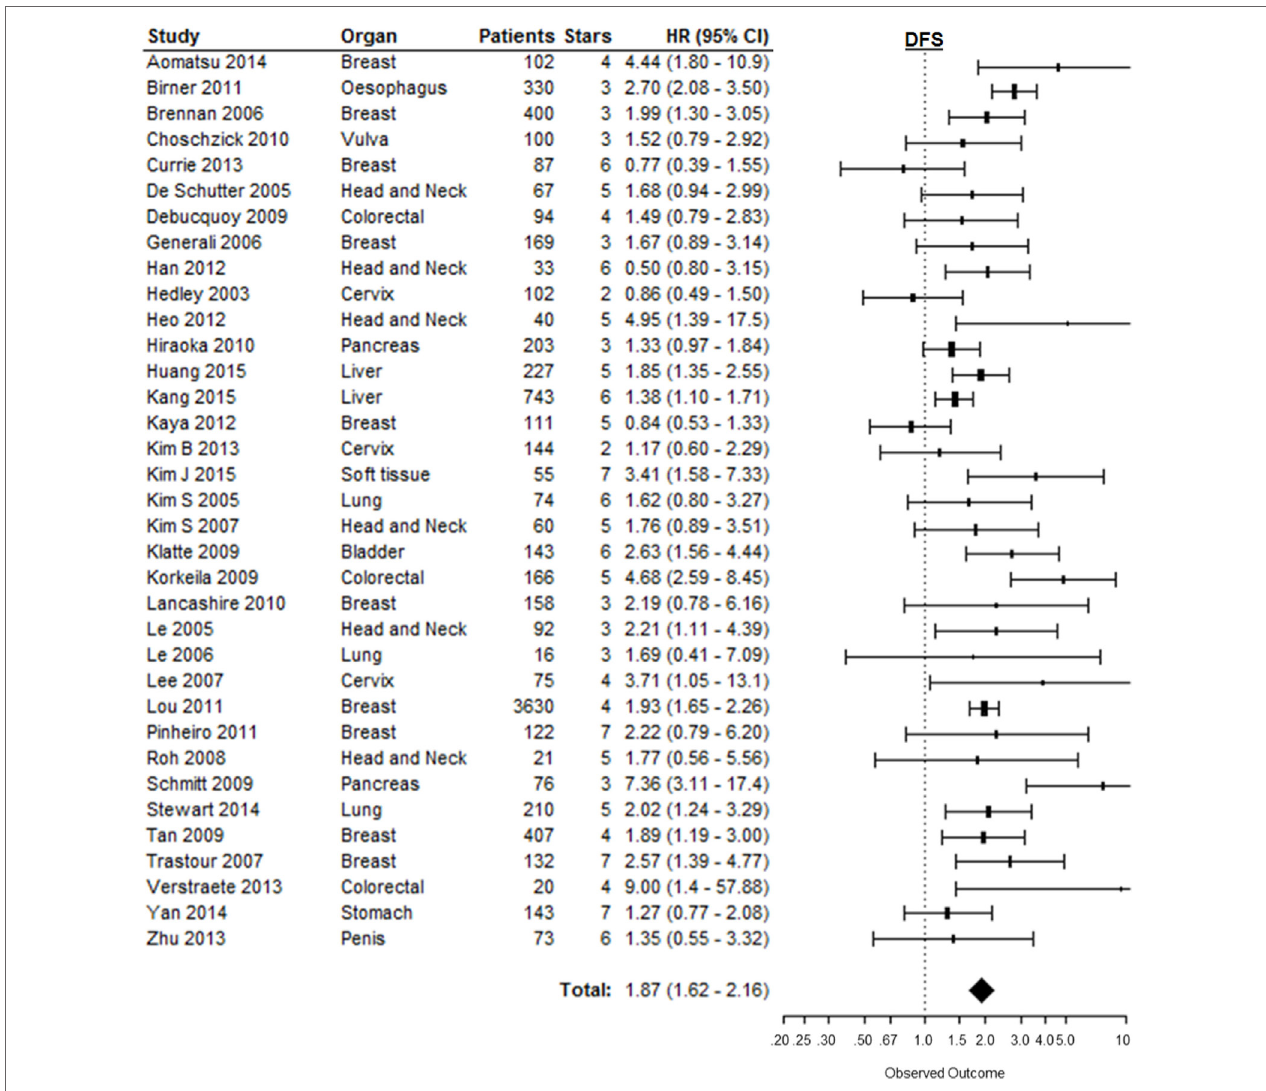
FiGURe 4 | Forest plot of the papers describing the association between CAiX expression and DFS . Horizontal bars represent HR with corresponding 95%CI. Symbol size represents the assigned weight of the study. The overall HR with 95%CI is visualized with the diamond shape. Dashed line indicates no association between CAIX and prognosis (29, 33, 34, 48, 57, 59, 68, 73, 74, 82, 84, 85, 87, 89, 90, 97, 98, 112, 117, 119, 121, 125,